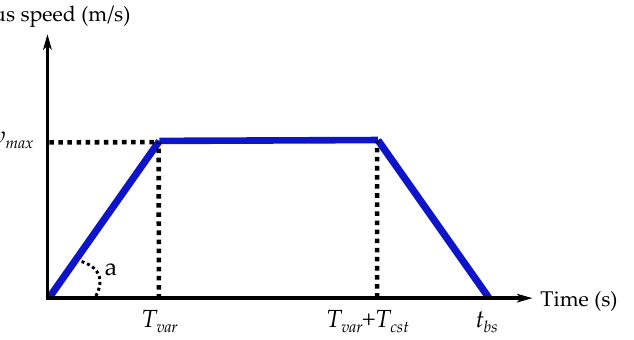
Figure 3. Bus speed profile in trapeze representing the travel between two bus stops. The trapezoid is defined by the maximal speed v max and the acceleration a .